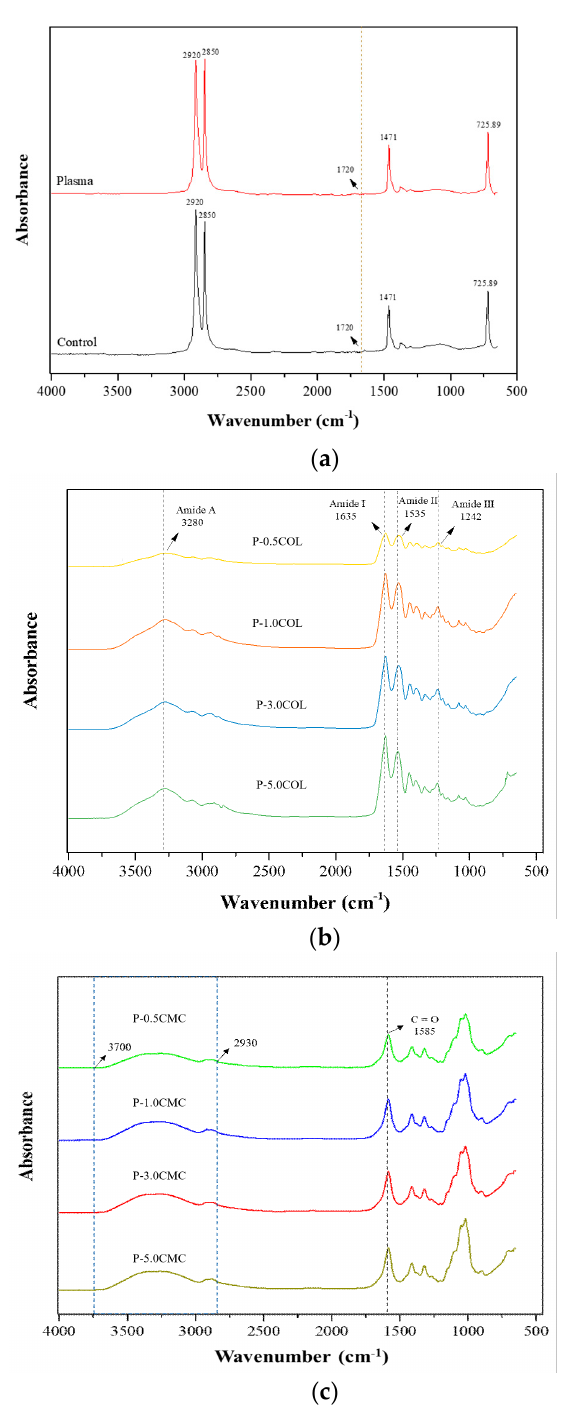
Figure 1. Surface functional groups of different films: ( a ) control, ( b ) COL group, and ( c ) CMC group.